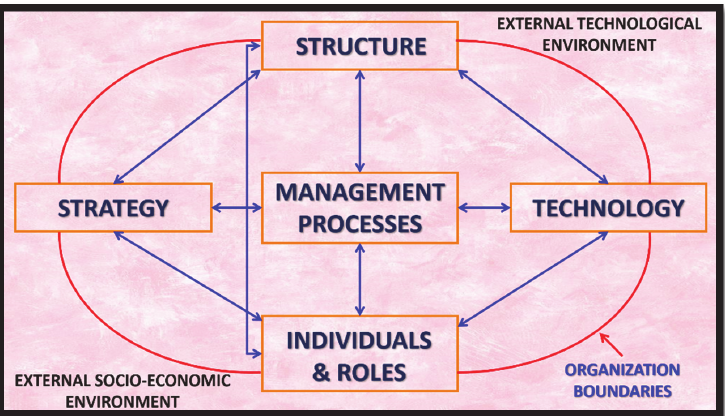
Fig. 1. The MIT90’s Model – for critical success factors for Information Technology (IT) and organi- zational digital transformation (Adapted from Scott Morton,